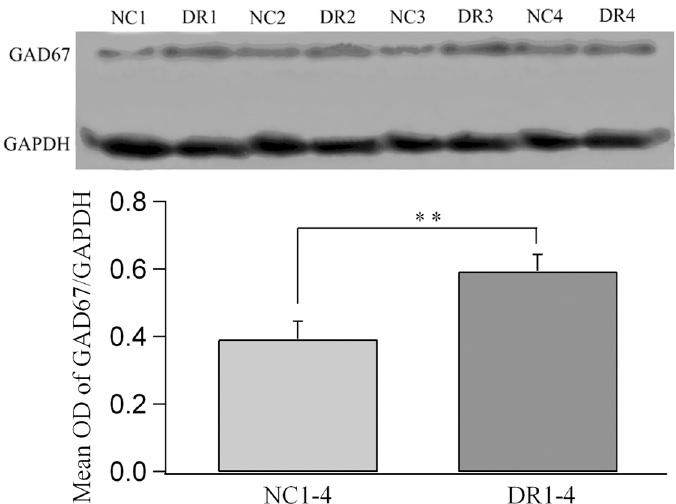
Fig 8. Comparison of the expression levels of GABA-synthesizing enzyme subunit, GAD67, between DR and normal control cats. The top panel shows a typical sample of a Western blot result from each DR cat (DR1-4) and control cat (NC1-4) using GAD67 and GAPDH (glyceraldehyde-3-phosphate dehydrogenase) antibodies. The bottom panel shows the average optical density (OD) of GAD67 bands normalized against the corresponding GAPDH in both groups of cats. The average normalized optical density of GAD67 in DR cats was significantly higher than that in the control ( ** p < 0.01).